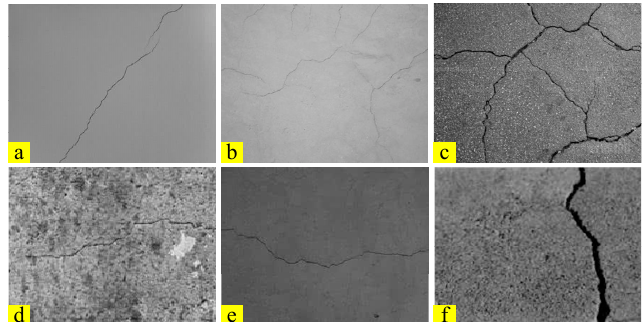
Figure 3. Examples of crack image: ( a ) clear and standard; ( b ) weak and disorderly; ( c ) noise; ( d ) dirty and blurred; ( e ) dark; ( f ) wide crack.